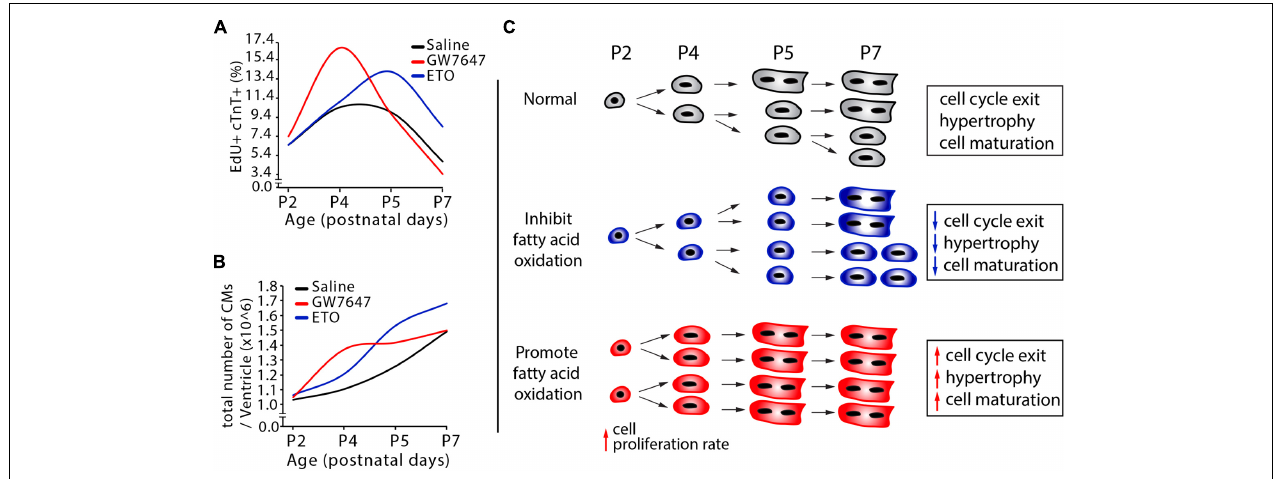
FIGURE 7 | Effects of fatty acid oxidation on cardiomyocyte proliferation in infant mice. (A,B) Quantification of postnatal cardiomyocyte DNA synthesis and cell number expansion in mice with either GW7647, ETO or saline treatment. (C) The graphs depict the changes in cardiomyocyte proliferation, hypertrophic growth and maturation based on data obtained by DNA synthesis and cell counting analysis ( Figures 3D–E , 5B–G